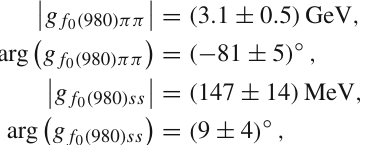
for the fits with an additional ρρ (top) and σσ (bottom) √ 3 s in the ¯ B 0 s decay